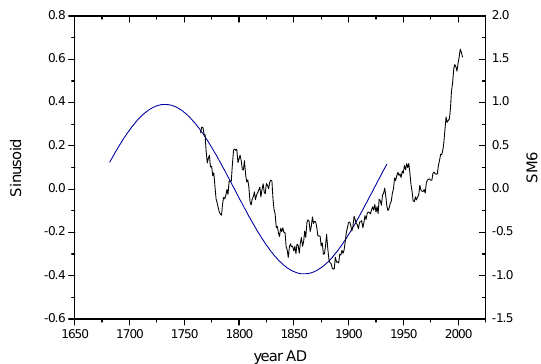
Fig. 3. Left panel: DFT of M6 (average from six central European instrumental time series). Right panel: same for SPA, interpolated time series of a stalagmite from the Austrian Alps for the period 500–1935AD. In both DFT analyses the records were padded with zeros. The upper confidence curve (brown) is for 95%, the lower (cyan) for 90% against background noise, each of those established by 10000 Monte Carlo runs. The most relevant peaks are indicated by their period length.